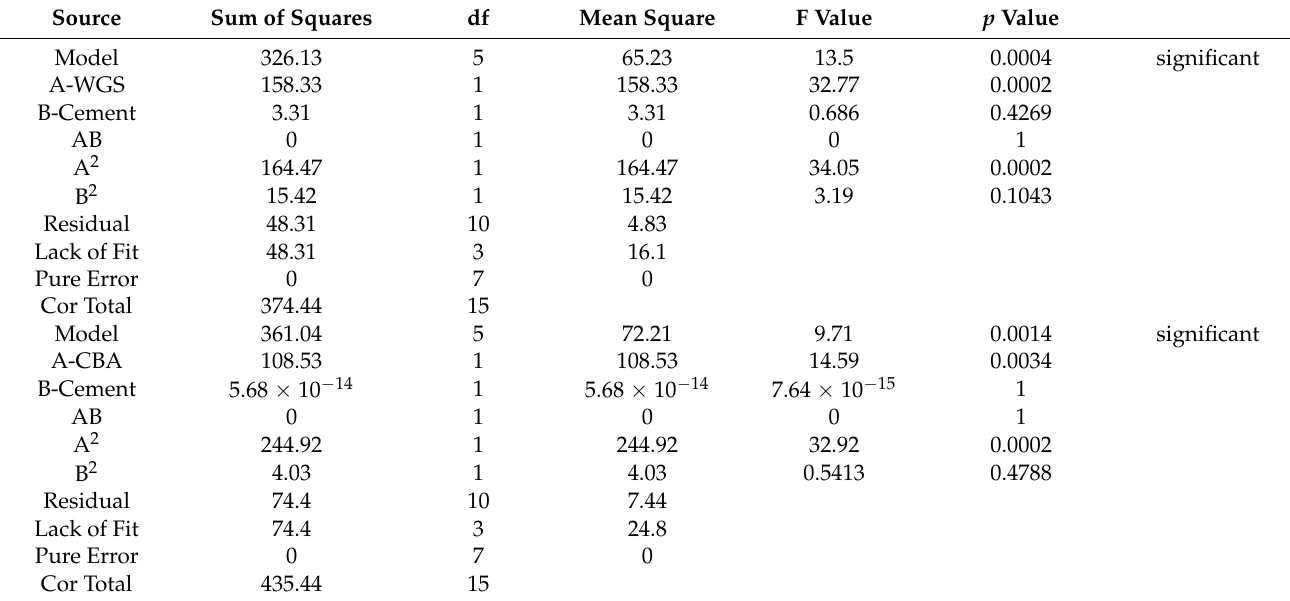
Table 5. ANOVA analysis of the response models.